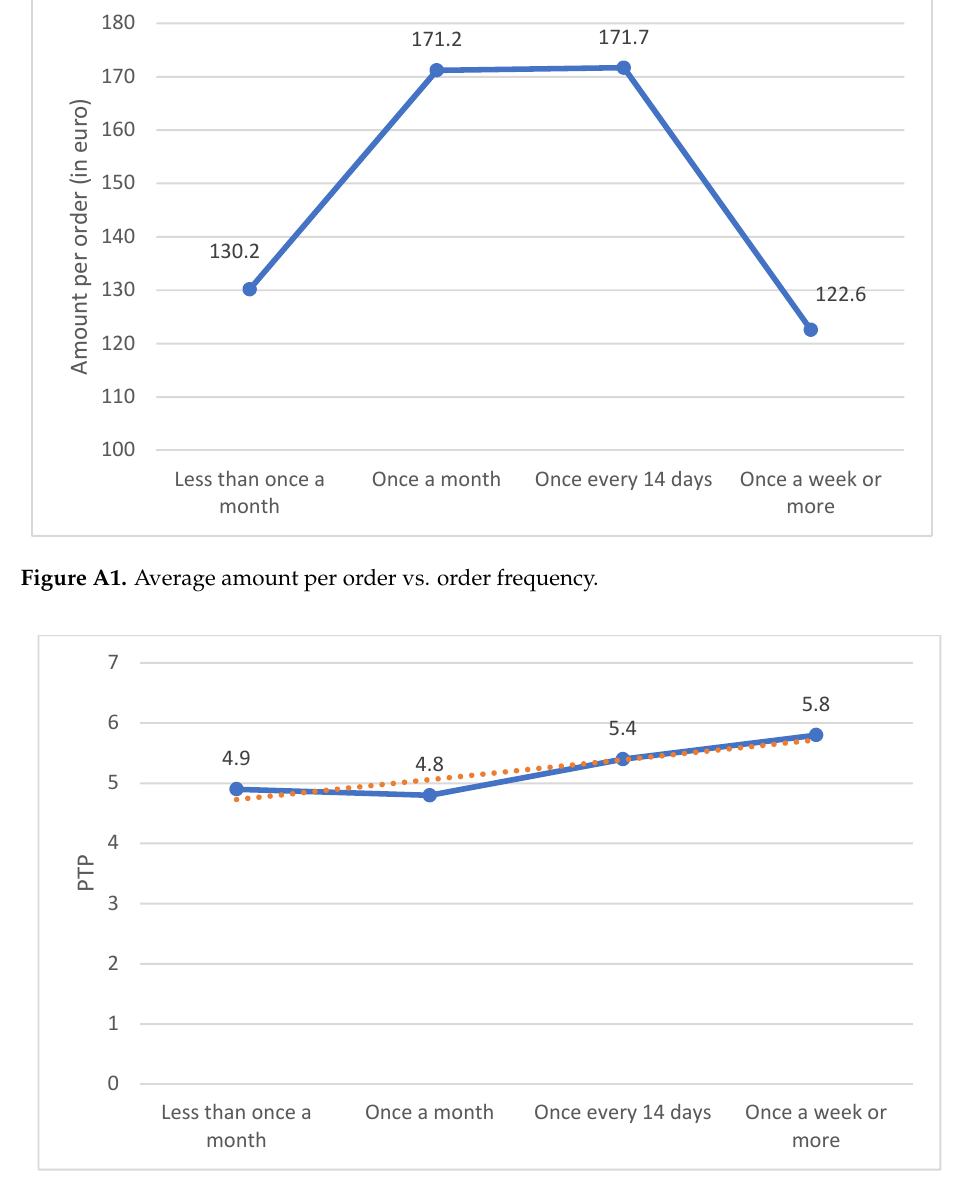
Figure A2. PTP vs. order